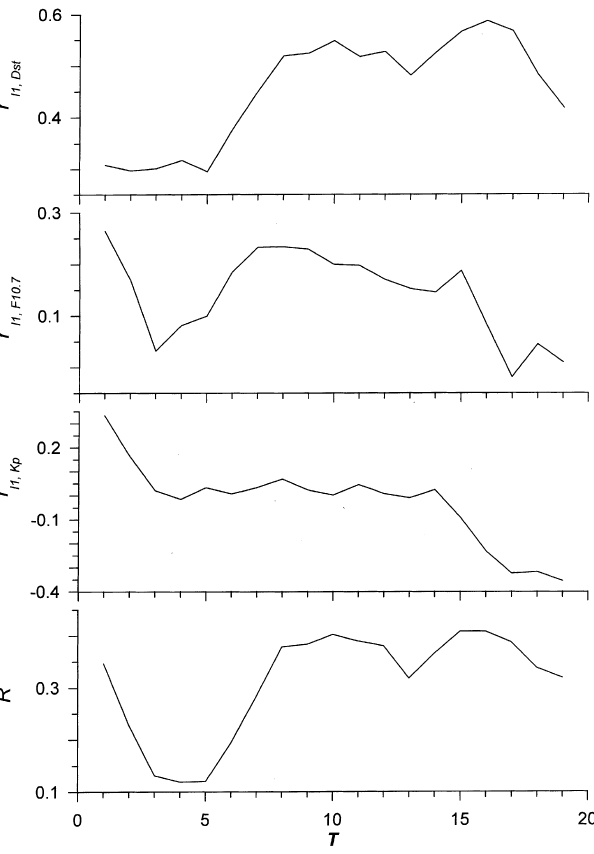
Fig. 6. Dependence of the partial